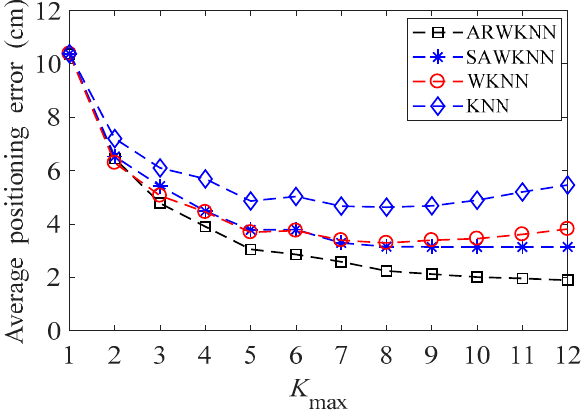
Figure 11. In 3-D, the impact of K max on the average positioning error.